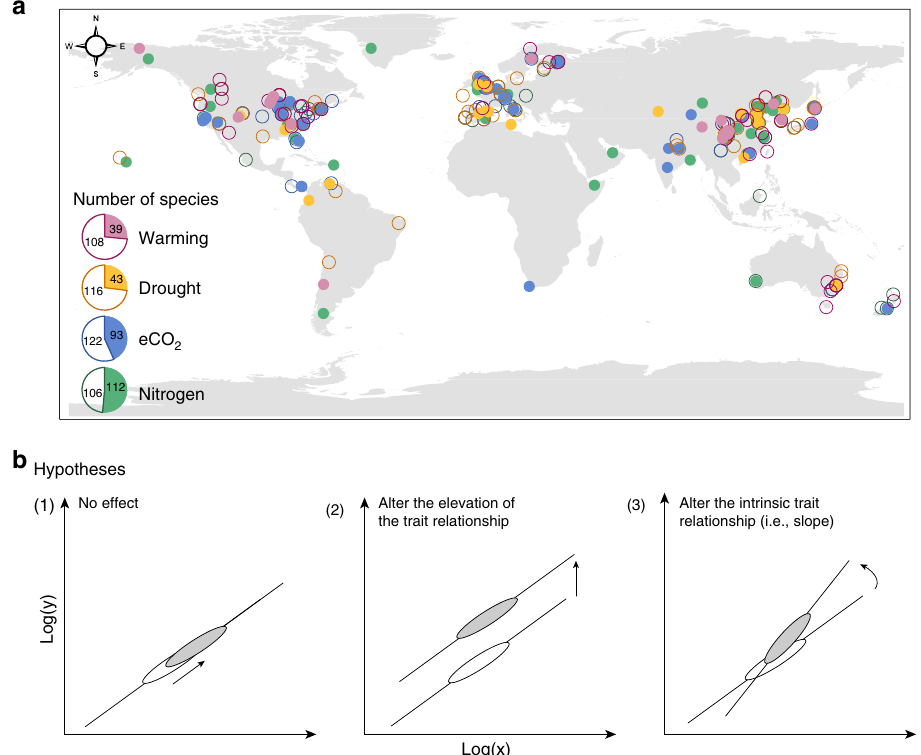
Fig. 1 Distribution of the global trait database and the hypotheses in this study. a Locations of the study sites in this dataset. The fi lled circles represent the distribution of fi eld experiments and the open circles for the locations of environmentally controlled experiments. The inset shows the number of species for environmentally controlled and fi eld experiments. Note that locations of the environmentally controlled experiments are determined by latitude and longitude of the experimental sites. b Hypotheses depicting possible effects of global environmental changes on log – log trait relationships (of the form log y ¼ k ´ log x þ b ). Here, we assumed that the trait relationships remain constant (1), the scaling exponents of the trait relationships remain unchanged but the elevation vary (2), and/or the interspeci fi c trait relationships vary (3) under global environmental changes. The arrows indicate the directions of trait